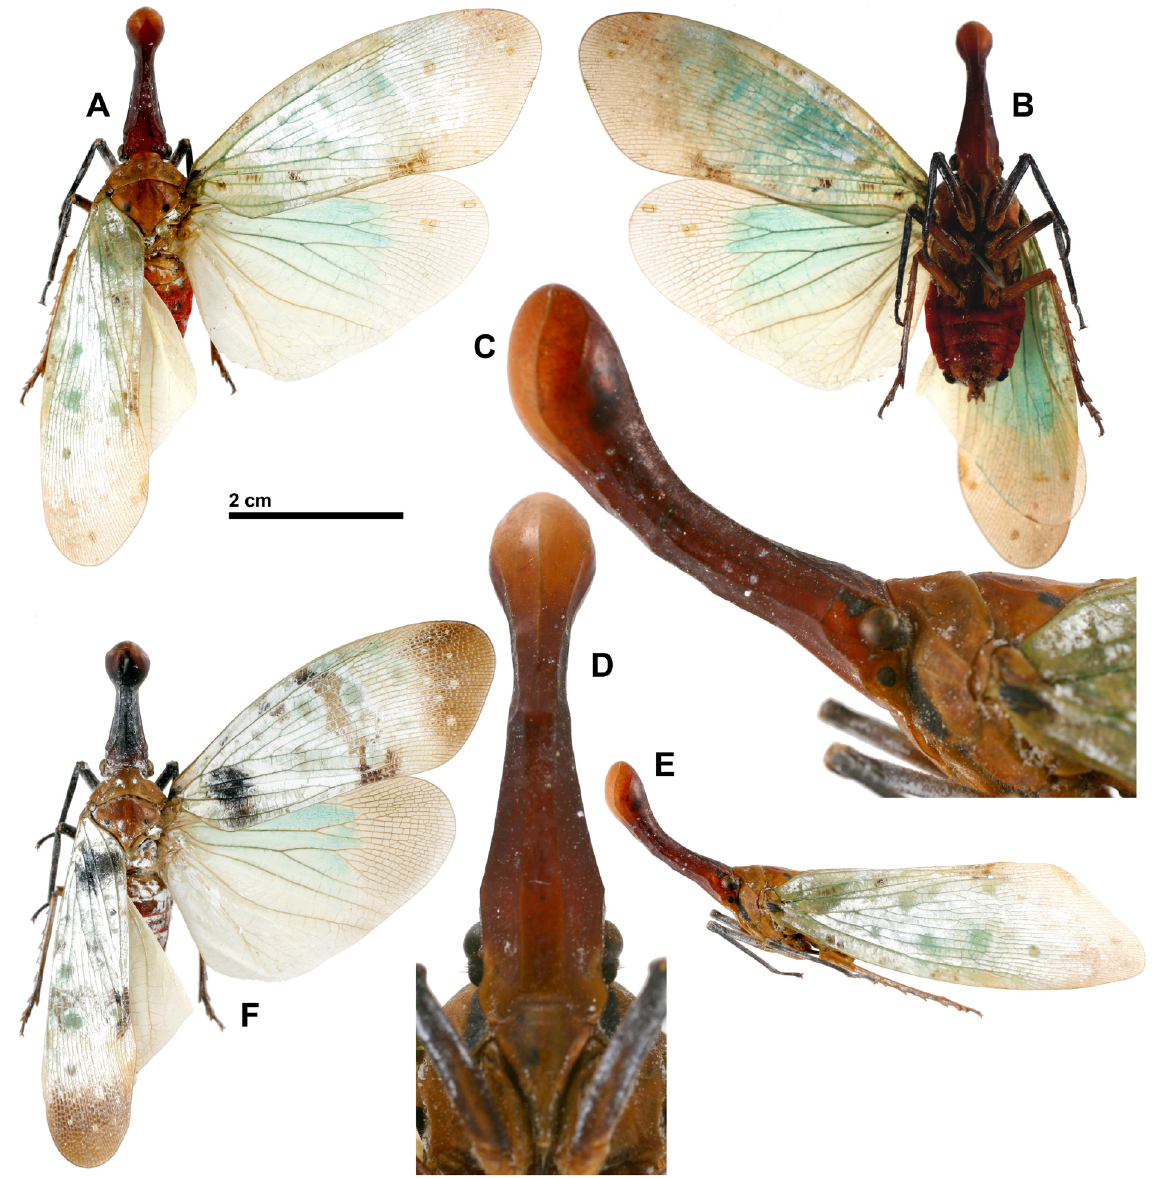
Fig. 3. Pyrops clavatus (Westwood, 1839), ♀♀, Thailand, Chiang Mai, Dec. 2007 (RBINS). A–E . Pale specimen. A . Habitus, dorsal view. B . Habitus, ventral view. C . Head and thorax, left lateral view. D . Head, normal view of frons. E . Habitus, left lateral view. — F . Intermediate specimen with cephalic process black dorsally, habitus, dorsal view. (C–D not